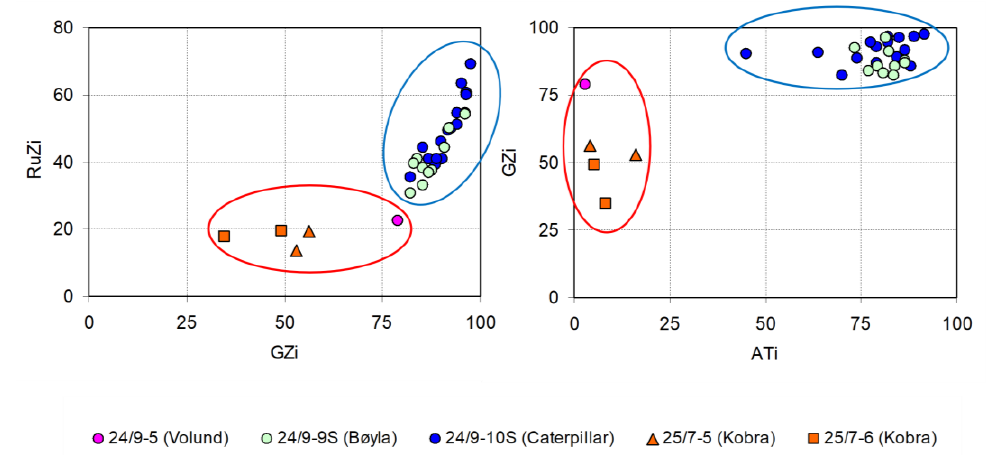
Figure 6. Crossplots of provenance-sensitive index parameters ATi, GZi and RuZi for Hermod S2 sandstones in the Greater Alvheim area. Note the marked difference between the characteristics shown by Caterpillar and Bøyla compared with Volund and Kobra. Based on clear differences in key HM indices, assemblages can be divided into northern Hermod S2 Mbr (circled in red) and southern Hermod S2 Mbr (circled in blue).